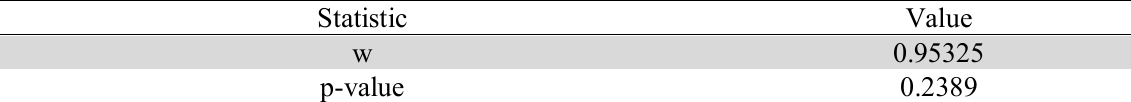
Fig. 8. Normal Q - Q plot of residuals Shapiro-Wilk normality test results